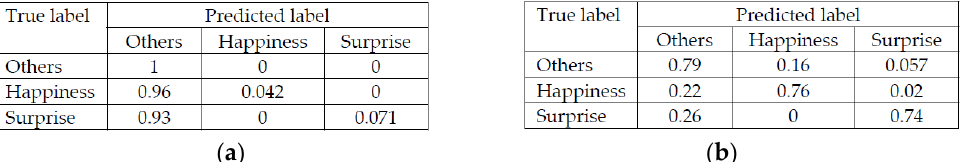
Figure 11. Confusion matrices of DS-3DCNN without domain adaptation: ( a ) SAMM dataset and ( b ) SMIC dataset.